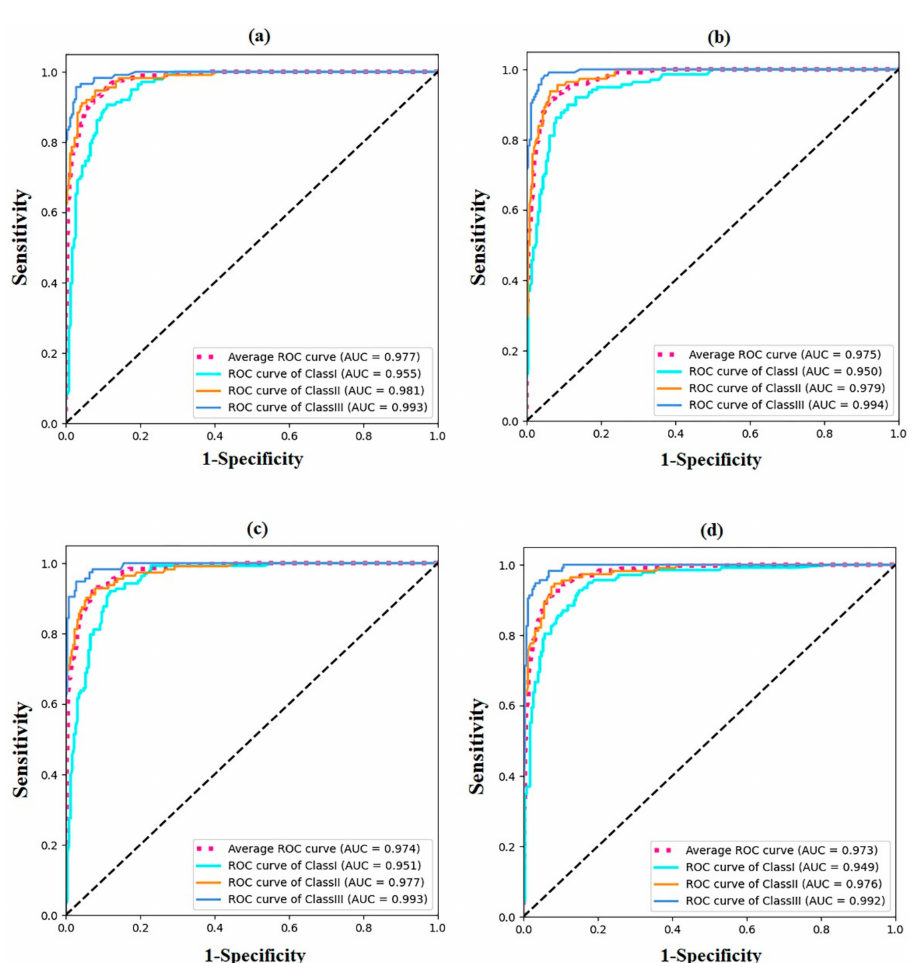
Figure 4. ROC curves of the four CNN models of the test sets. All four CNNs models have good ability to classify the sagittal skeletal patterns. ( a ) DesneNet161; ( b ) ResNet152; ( c ) VGG16; ( d ) GoogLeNet.